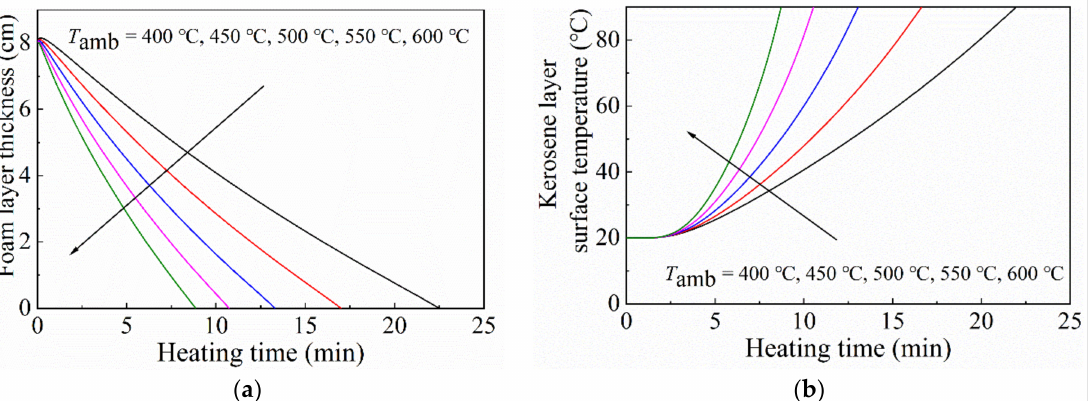
Figure 7. Curves of ( a ) the foam layer thickness and ( b ) surface temperature of the kerosene layer with different heating temperatures. The particle concentration was 1.0 vol%, and the particle size was 30 nm. The initial thickness of the foam layer was 8.0